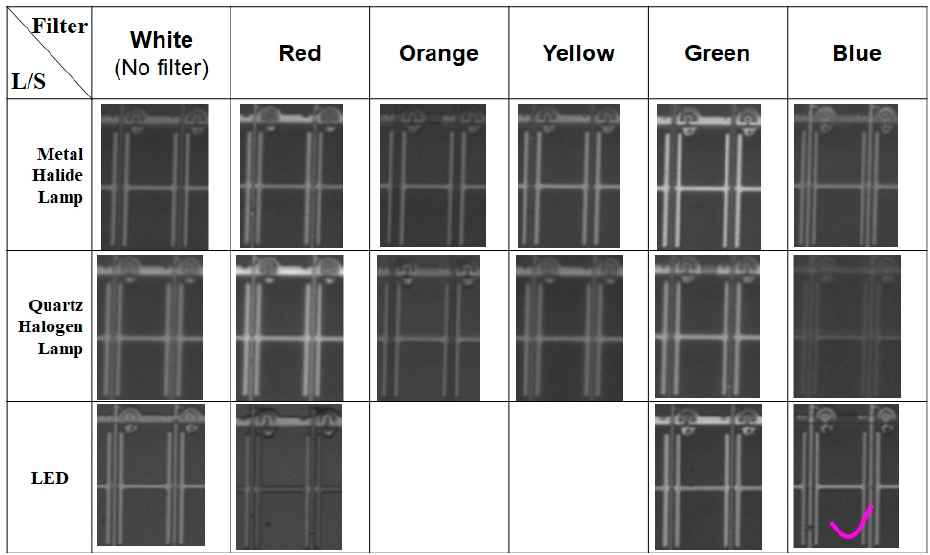
Figure 5. The third layer circuit pixel by various lamps for optical detection in TFT.